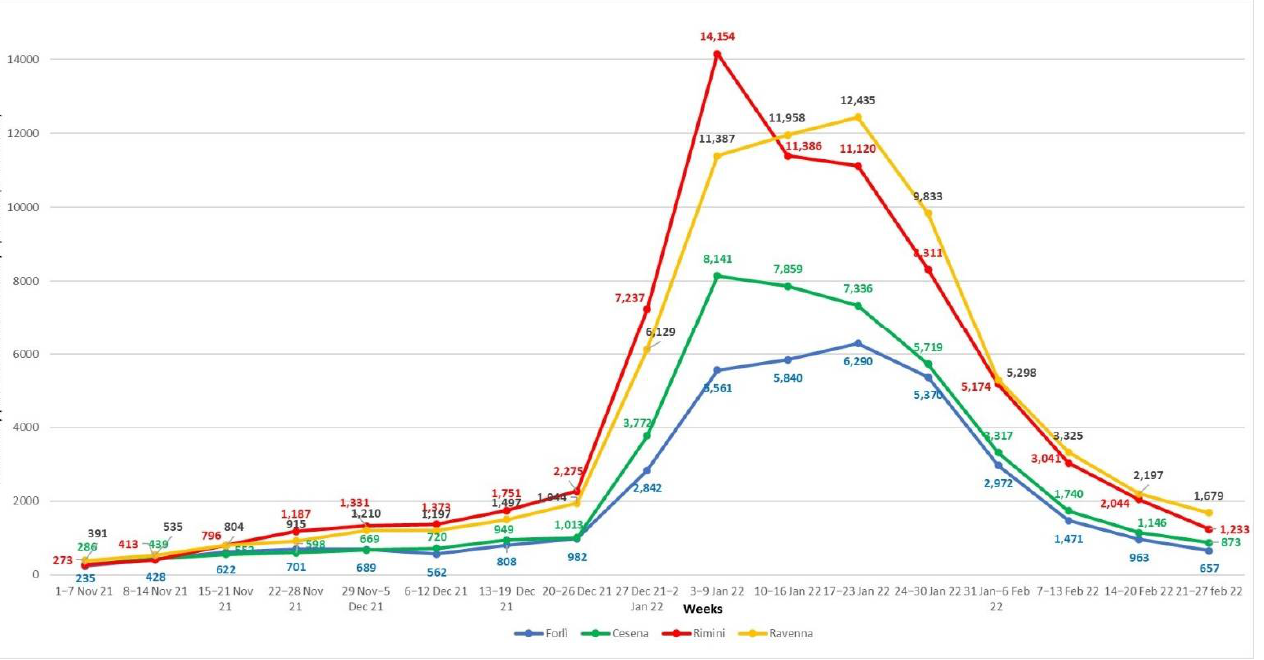
Figure 1. Weekly confirmed COVID-19 cases were divided according to Romagna territorial districts (Forlì, Cesena, Rimini and Ravenna) from 1 November 2021 to 28 February 2022.